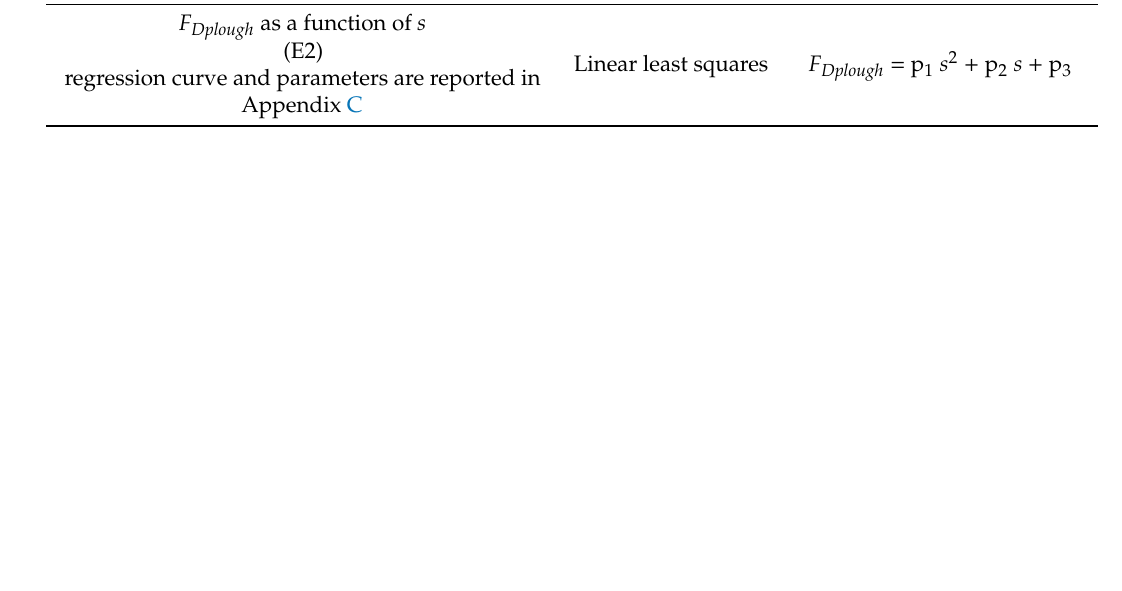
Table 6. Regression curves for F Dplough as a function of s (TT in 8th gear). Curves